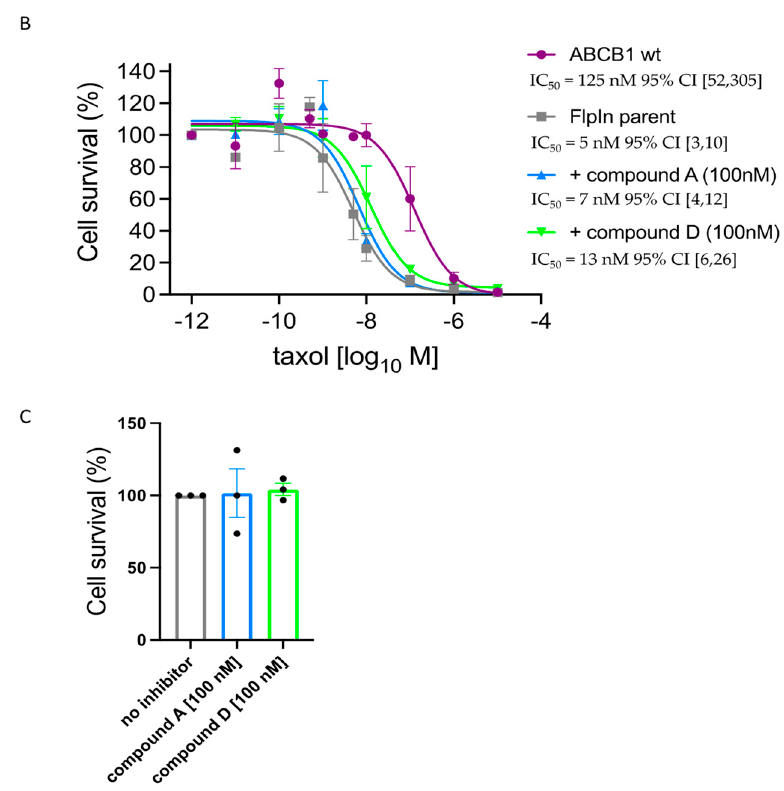
Figure 5. Potency of test compounds ‘A’ and ‘D’ to inhibit OG-taxol efflux and to resensitise ABCB1- expressing cells to taxol. ( A ) Histograms showing inhibition of OG-taxol efflux by Flp-In-ABCB1 cells in the presence of 100 nM test compounds ‘A’, ‘D’, ‘E’, and ‘F’ (gating as per Figure 1). ( B ) Non-linear regression analysis of cell number after three-day culture in taxol in the presence or absence of test compounds ‘A’ and ‘D’ at 100 nM. Data are normalized to cell number at zero taxol concentration. IC 50 data with 95% confidence intervals are calculated ( n = 3 biological repeats). The IC 50 for taxol calculated for the ABCB1 wild-type cells in the absence of inhibitor is statistically different to all other datasets ( p < 0.001), while the IC 50 for taxol for the Flp-In parental cell line is indistinguishable from the ABCB1 wild-type cells incubated in the presence of compounds ‘A’ and ‘D’. ( C ) Compounds ‘A’ and ‘D’ at 100 nM do not inhibit cell growth of the Flp-In parental cells. Data are normalised to 100% in the absence of inhibitor. t -tests on the raw paired data showed no significant difference.